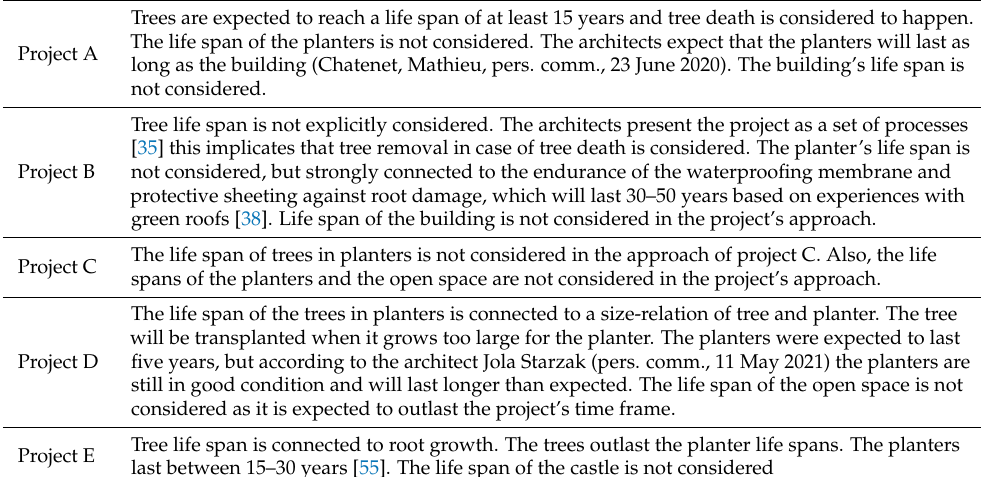
Table 2. Life spans considered in the five analysed